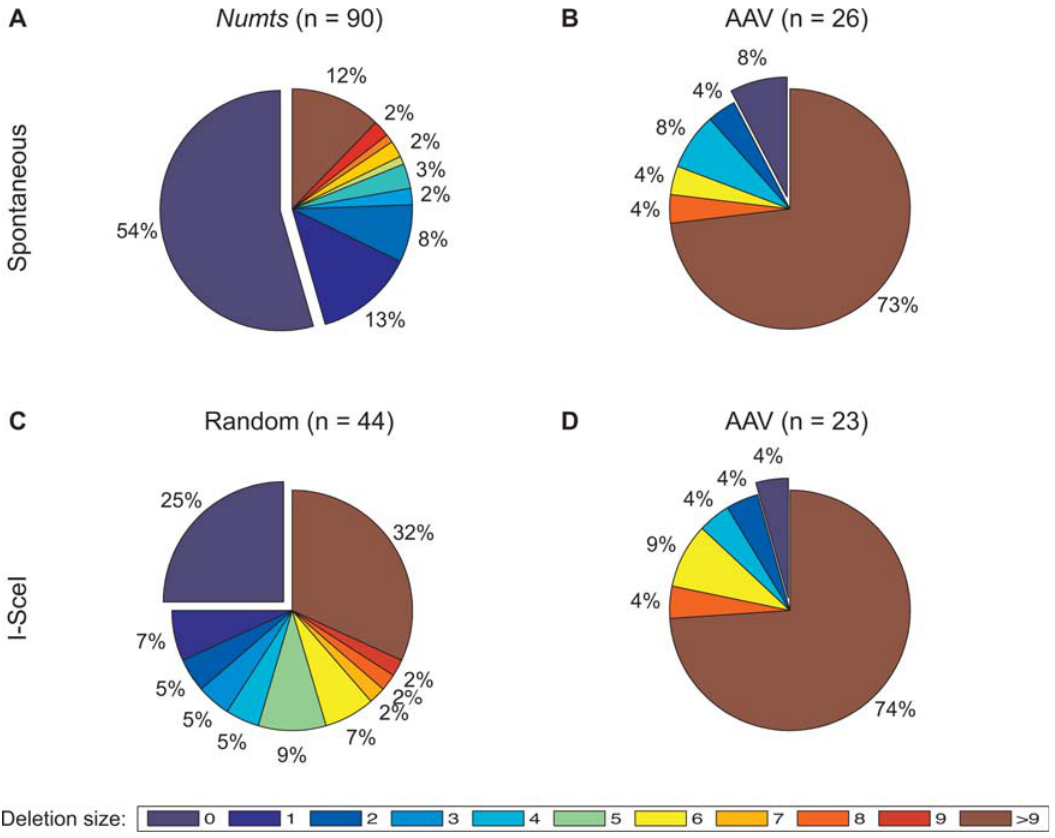
Figure 4. Numt insertions involve reduced loss of chromosomal nucleotides. Pie diagrams show the distribution of deletion sizes in our study and different experimental systems with filler DNA (A) numt -mediated repair usually involves either no deletions or small 1–2 base deletions, (B) Spontaneous integration of AAV [56–58] (C) Random integration into I-SceI [12,13,55], and (D) Integration of AAV into I-SceI [56] include more deletions. One-tail Fisher exact tests (presence/absence of deletions, numt versus spontaneous AAV P =9.5 6 10 2 6 , numt versus AAV P =4.7 6 10 2 6 , and numt versus random P =0.001) were statistically significant. Similarly, the meanrank deletion size in the numt group is significantly smaller than in the other groups (Kruskal–Wallis nonparametric ANOVA n=183, P =10 2 13 ; A posteriori Tukey-Kramer test P =0.01). Scale is 0–9 bases, and deletions bigger than 9. Offset slice shows no deletions. A detailed list of deletion size for all non- numt events appears in Table S3.